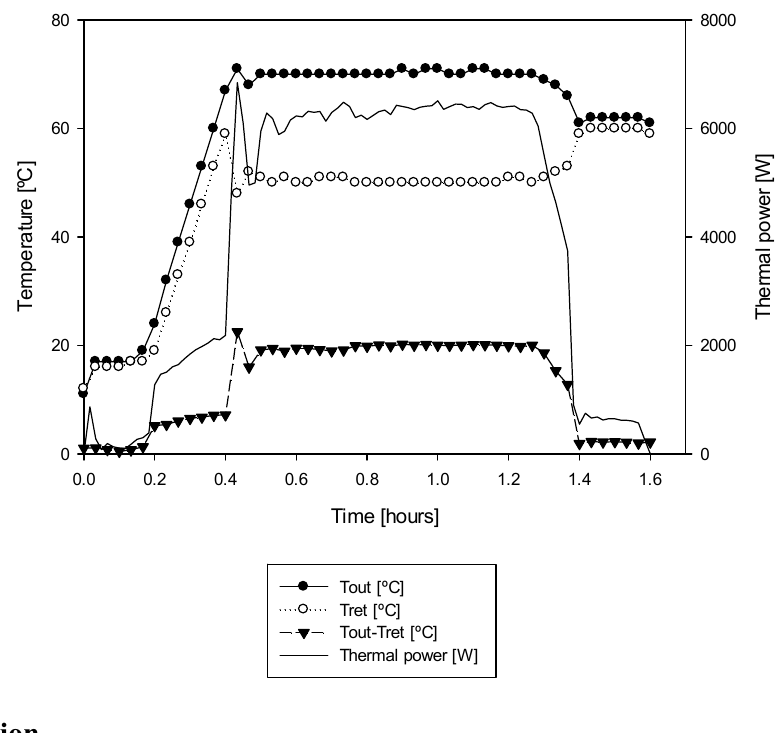
Figure 7. Thermal power and input and output water